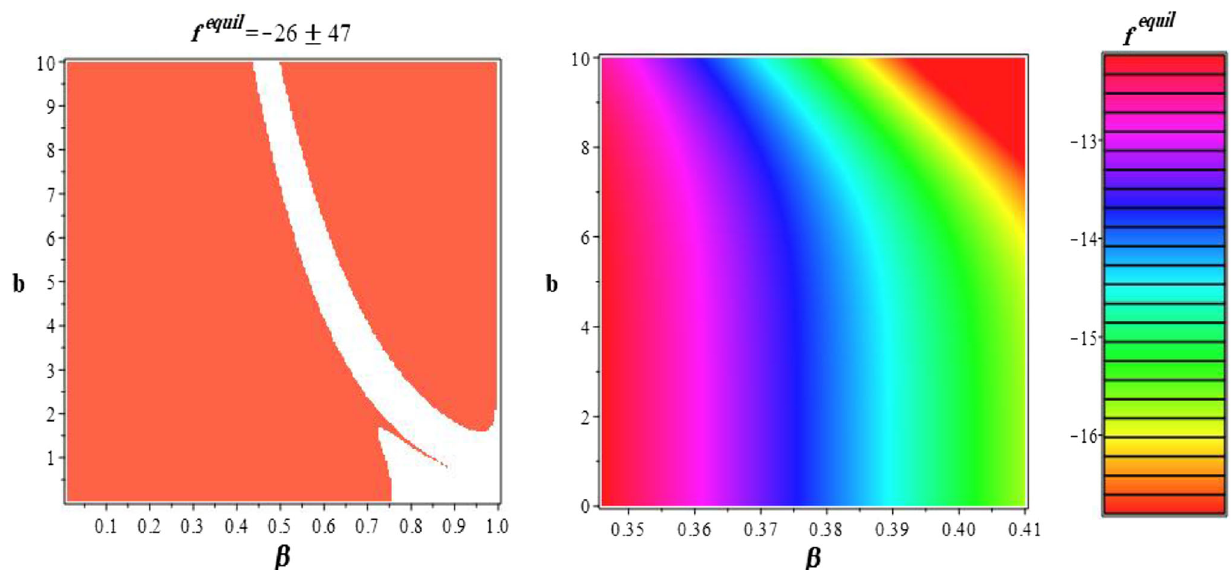
Fig. 9 The left panel shows the ranges of the intermediate MDBI model’s parameters leading to the observationally viable values of the equilateral non-Gaussianity. The right panels show the prediction of the intermediate MDBI model for equilateral non-Gaussianity. These figures have been plotted for N =